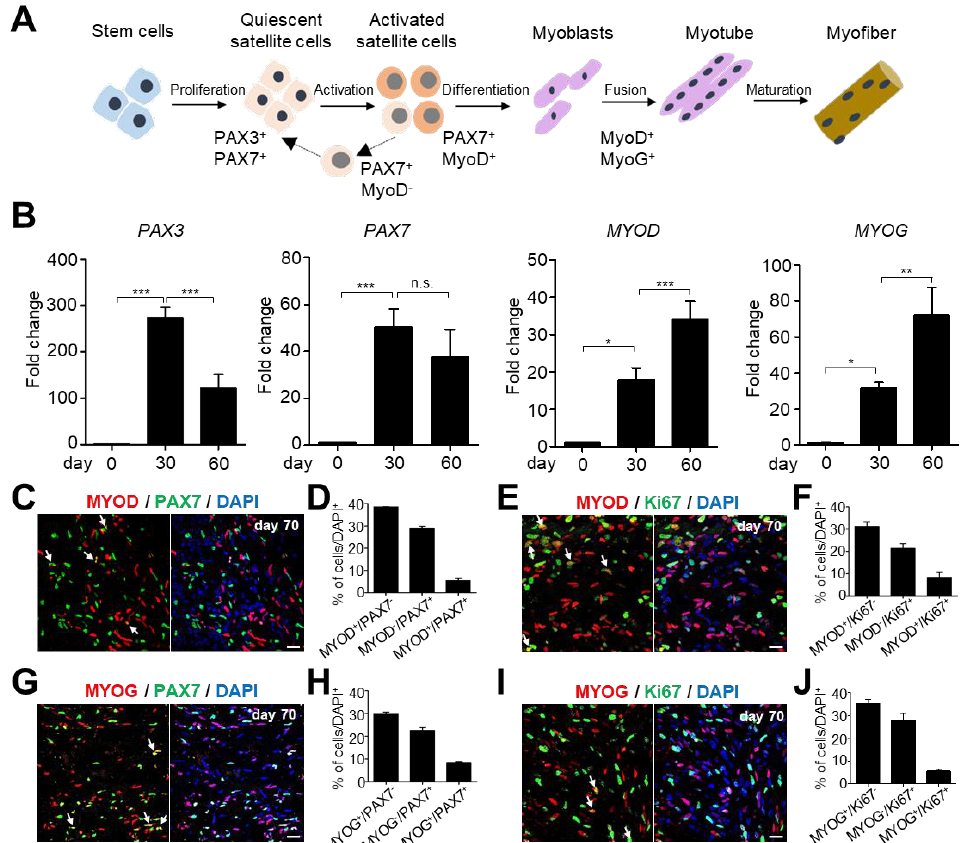
Figure 2. Characterization of SCs in hSkMOs. ( A ) Schematic representation of skeletal muscle differ- entiation and specific markers for each stage. ( B ) qRT-PCR data demonstrating the relative expression of SC (PAX3 and PAX7), activated SC (myoblast determination protein 1 (MYOD)), and myocyte (myogenin (MYOG)) markers at days 30 and 60 of hSkMOs. The qRT-PCR data were normalized to GAPDH expression. The bar graph represents the fold change in gene expression between the sample groups. Statistical analysis was performed using one-way ANOVA, followed by Tukey’s multiple comparison test. * p <0.05, ** p <0.01, *** p <0.001; n.s., not significant. ( C ) Cryosections of day 70 hSkMOs stained with specific antibodies against MYOD and PAX7. The quantifications are represented in ( D ); mean ± s.e.m., n = 3. ( E ) Cryosections of day 70 hSkMOs stained with specific antibodies against MYOD and Ki67. The quantifications are represented in ( F ) as mean ± s.e.m., n = 3. ( G ) Cryosections of day 70 hSkMOs stained with specific antibodies against MYOG and PAX7. The quantifications are represented in ( H ) as mean ± s.e.m., n = 3. ( I ) Cryosections of day 70 hSkMOs stained with specific antibodies against MYOG and Ki67. The quantifications are represented in ( J ); mean ± s.e.m., n = 3. Scale bars, 20 µ m. White arrows indicate double-positive